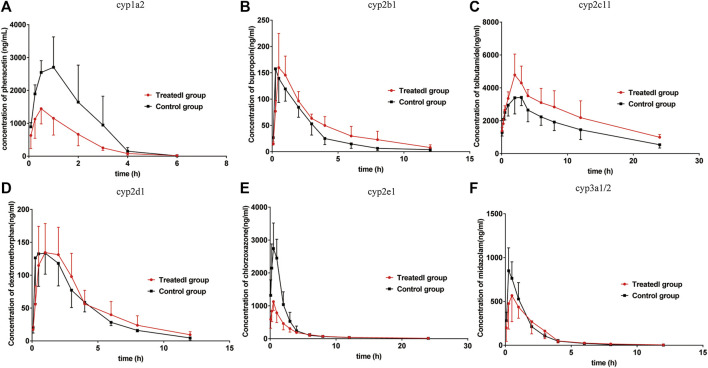
Mean plasma concentration-time curves of (A) phenacetin (CYP1A2), (B) bupropion (cyp2b1), (C) tolbutamide (cyp2c11), (D) dextromethorphan (cyp2d1), (E) chlorzoxazone (cyp2e1), and (F) midazolam (cyp3a1/2) in rats (mean ± SD, n = 6).